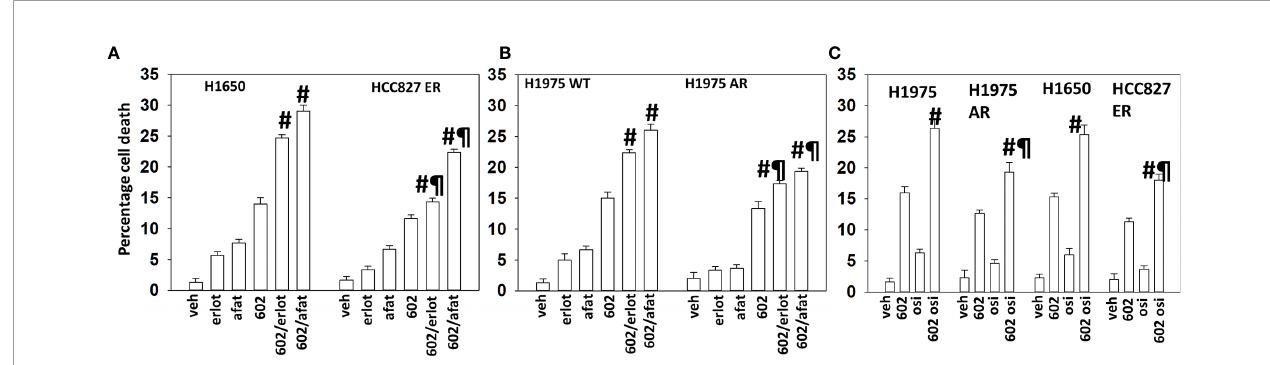
FIGURE 1 | GZ17-6.02 interacts with ERBB1 inhibitors to kill NSCLC cells expressing mutant active forms of ERBB1. (A, B) H1650, wild-type sensitive, and afatinib-resistant (AR) H1975 and erlotinib-resistant (ER) HCC827 cells were treated with vehicle, erlotinib (500 nM), afatinib (500 nM), GZ17-6.02 (2 m M curcumin fi nal), or the drugs in combination for 24 h. Cell viability was determined by trypan blue exclusion ( n = 3 ± SD). # p < 0.05 greater than GZ17-6.02 alone; ¶ p < 0.05 less than the corresponding values in drug-sensitive cells. (C) H1650, wild-type sensitive, and afatinib-resistant (AR) H1975 and erlotinib-resistant (ER) HCC827 cells were treated with vehicle, osimertinib (100 nM), GZ17-6.02 (2 m M curcumin fi nal), or the drugs in combination for 24 h. Cell viability was determined by trypan blue exclusion ( n = 3 ± SD). # p < 0.05 greater than GZ17-6.02 alone; ¶ p < 0.05 less than the corresponding values in drug-sensitive